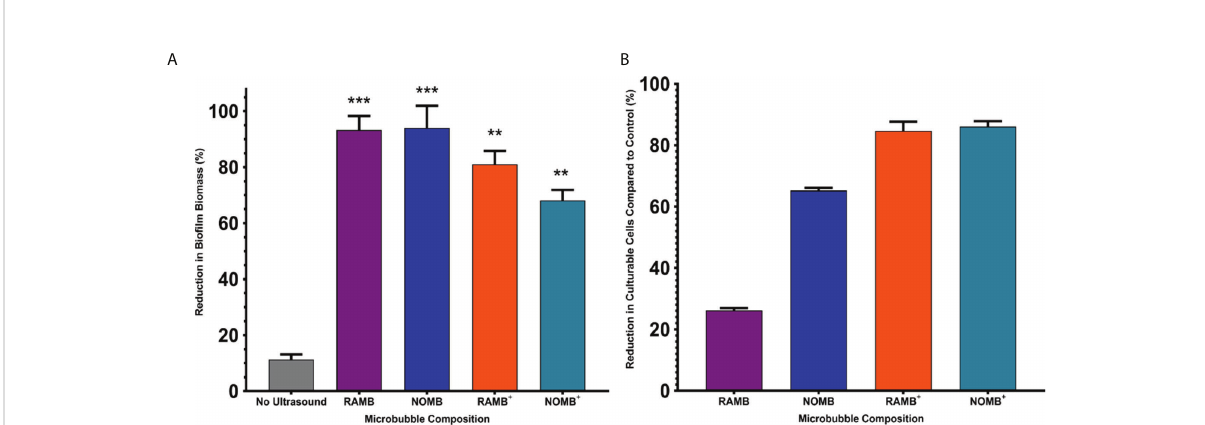
FIGURE 2 (A) The percentage reduction in P. aeruginosa bio fi lm biomass reported here, was determined by calculating the change in surface area of the live/dead stained bio fi lm before and after treatment in a 1 cm 2 area. The four principal MB formulations: uncharged RAMBs and NOMBs and cationic RAMBs+ and NOMBs+ were stimulated without antibiotic using an ultrasound driving frequency of 0.9 MHz, duty cycle of 20% and a 500 Hz PRF; 45 Vpp was applied to the transducer to reach an acoustic pressure of 0.5 MPa at the target site for 40 s. Error bars indicate standard deviation of the mean; signi fi cant differences in the reduction of biomass between each MB formulation and the unstimulated control, are indicated as ** P = < 0.0005 and *** P = < 0.0001 above the relevant bar. (B) The viability of the total bio fi lm biomass detached during ultrasound stimulation of MBs, was assessed by quantifying the average reduction in CFU/mL compared to an untreated control; error bars indicate standard deviation of the mean. The untreated control bio fi lms were exposed to the MB application process, but not stimulated with ultrasound. No antibiotic was applied during the treatment process at any stage, the results therefore represent only the ef fi cacy of the ultrasound stimulated MB